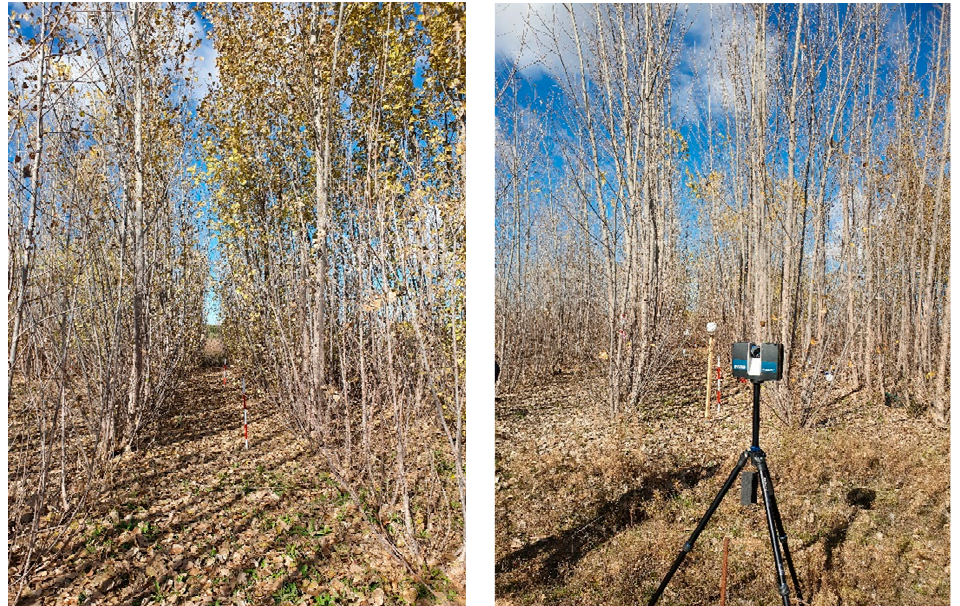
Figure 2. Detail of one of the study plots ( left ), and the target spheres and the FARO Focus 3D M70 scanner during the scanning process ( right ).